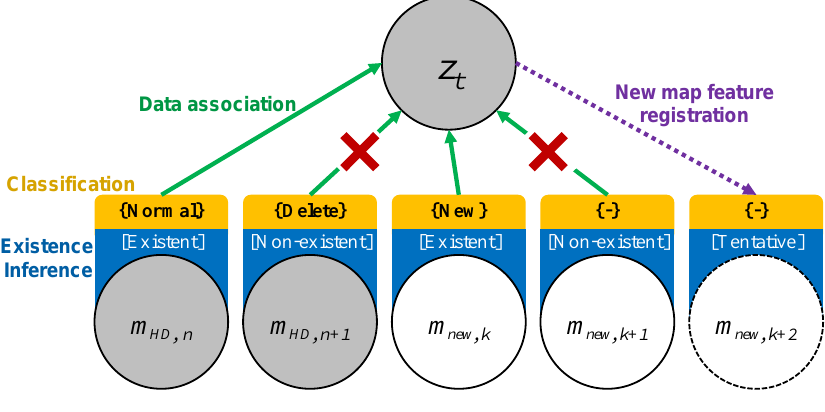
Figure 5. Process of the map change